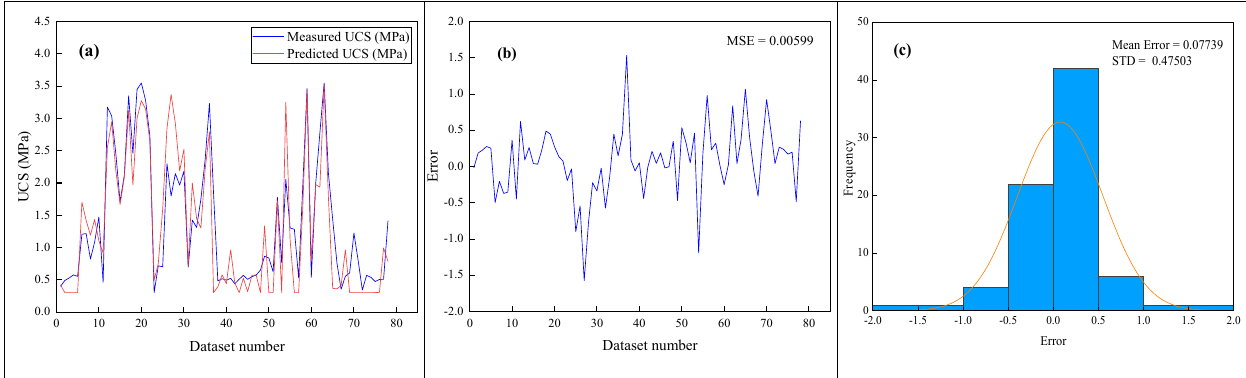
Figure 10. The demonstration of ANN model M1 for UCS. ( a ) Model M1 results aggregated with measured UCS. ( b ) The variation in error between the measured and predicted values. ( c ) Error histogram.